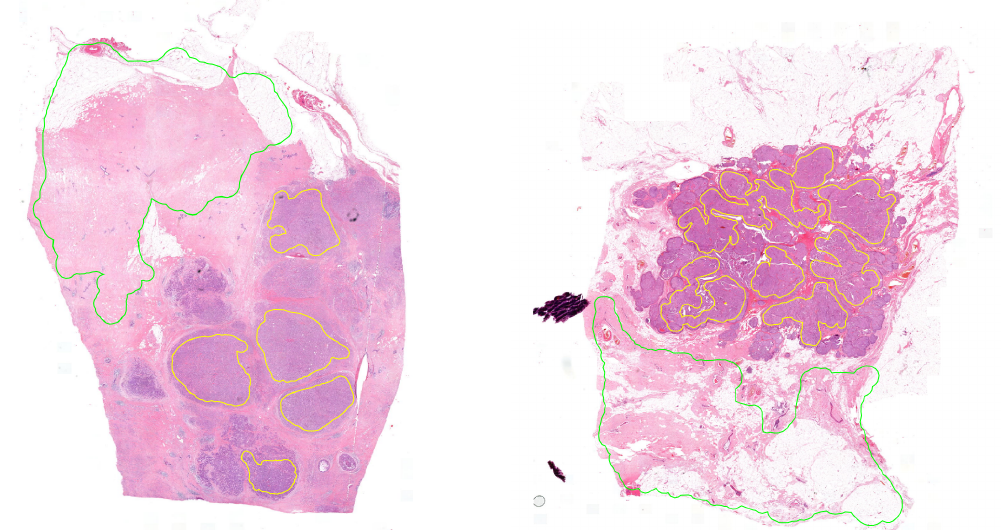
Figure 2. Examples of annotated histopathology images. Yellow annotation: tumor, green annotation: normal tissue.